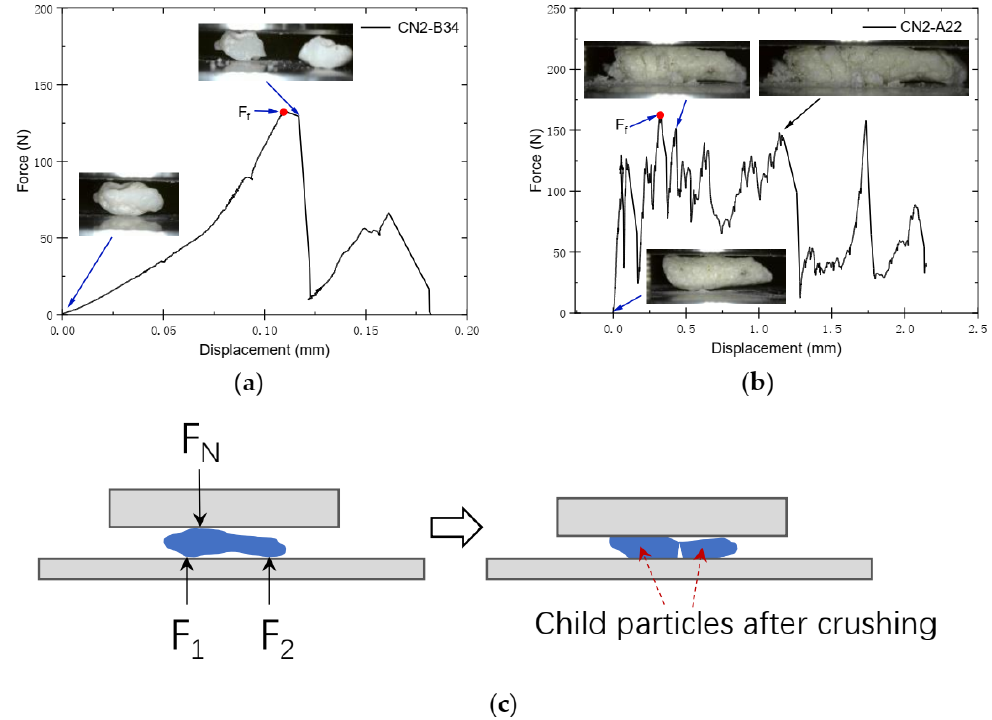
Figure 8. ( a ) Typical splitting mode failure; ( b ) typical progressive fracture mode failure; ( c ) elongated particle breakage schematic